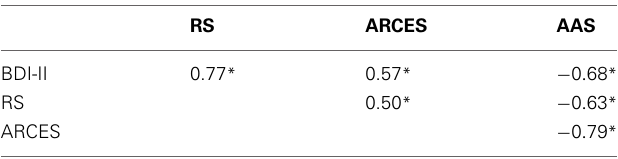
Table 2 | Correlations between demographic and mood variables across the entire sample ( N = 43).